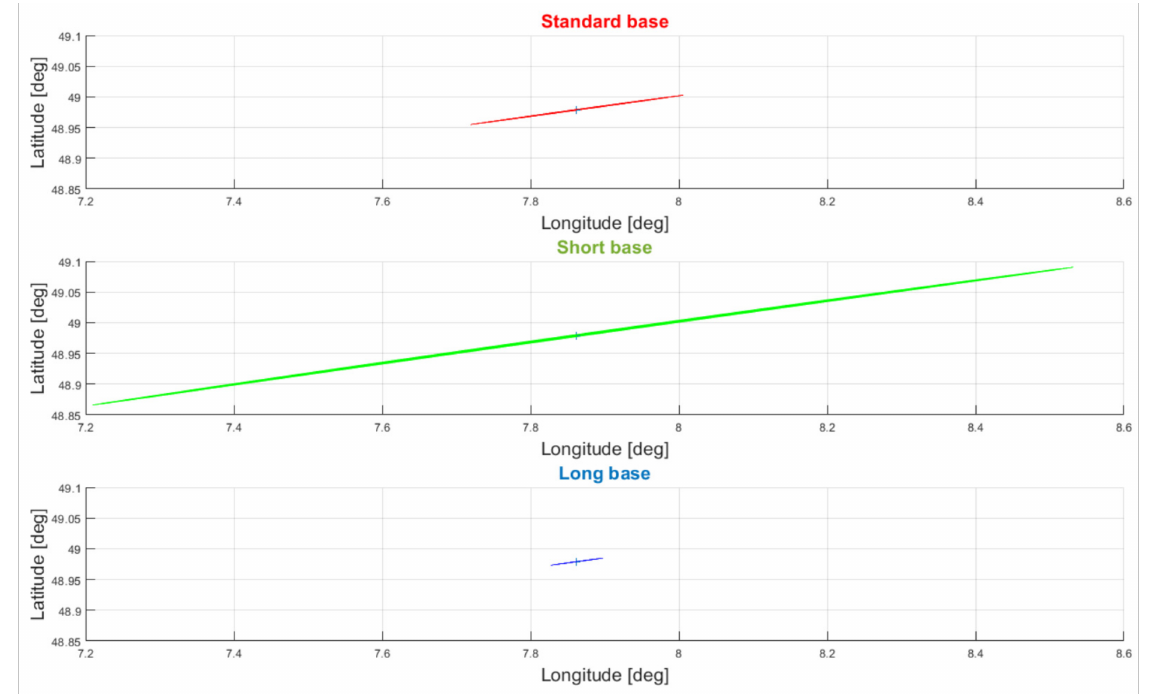
Figure 14. Sections of error ellipsoids in longitude to latitude plane (2D).